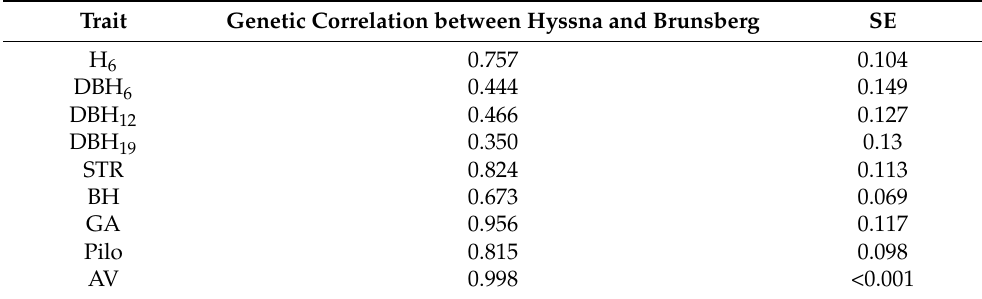
Table 4. Genetic correlations between the same traits measured at two sites (Hyssna and Brunsberg). SE is standard error.